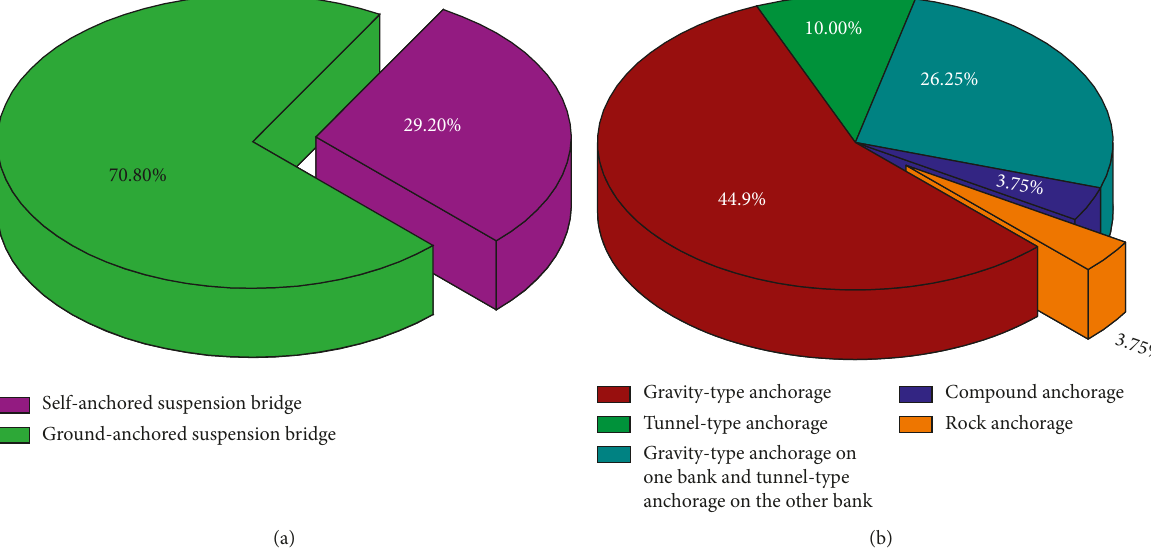
Figure 3: (a) Proportion of self-anchored and ground-anchored suspension bridge. (b) Statistical results of anchorage form of ground- anchored suspension